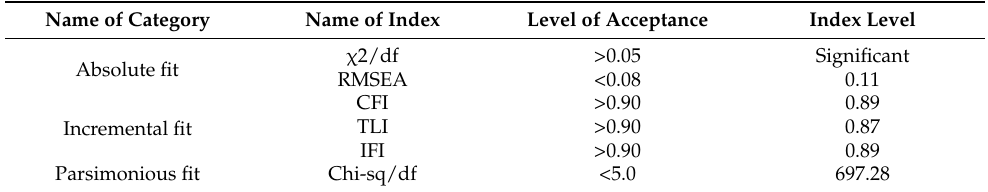
Table 5. Index level for the initial